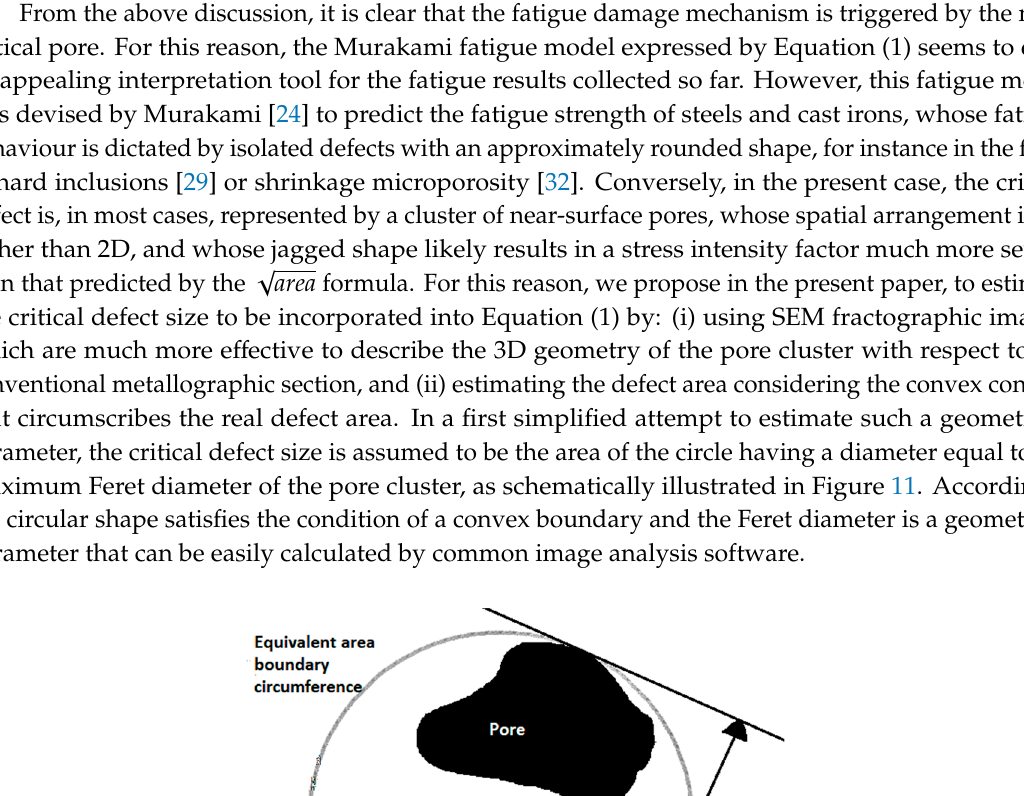
Figure 10. Non-propagating cracks found by SEM inspection in the DDH variant. ( a ) Cluster of pores interconnected by the crack, ( b ) single pore.